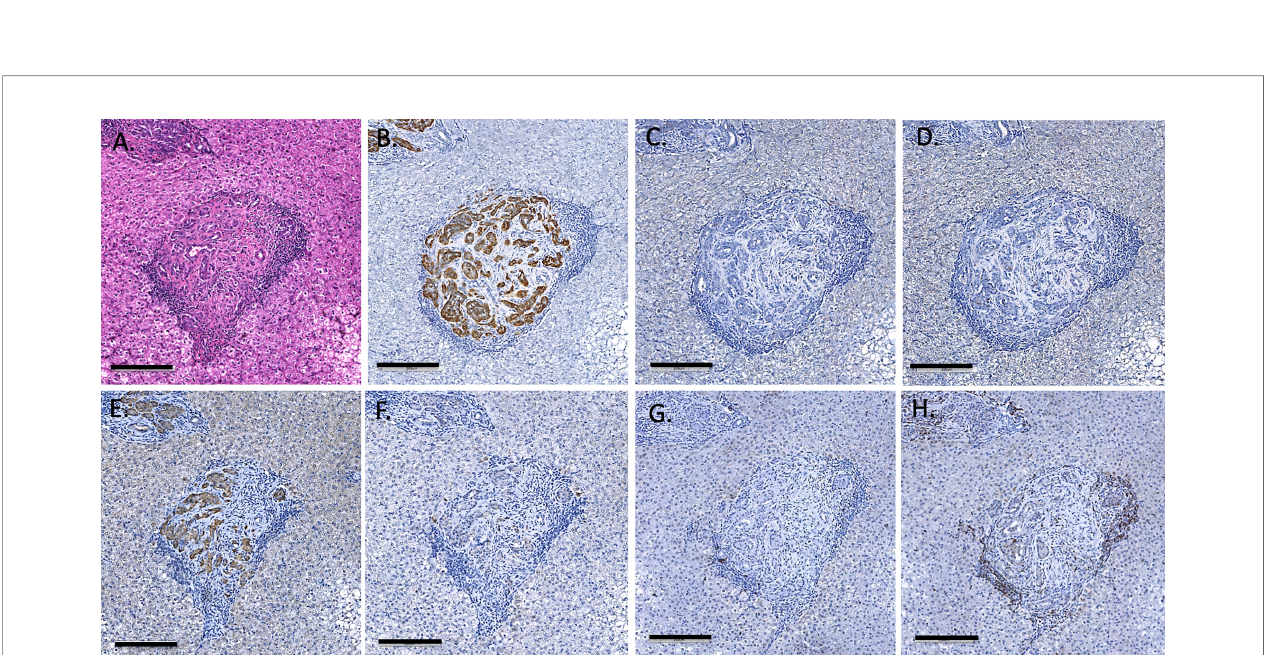
FIGURE 10 | Endpoint (day 675) liver biopsy of recipient B1, showing large islets staining with H&E (A) insulin (B) , glucagon (C) , somatostatin (D) , CD55 (E) and CD59 (F) , CD20 (G) and CD3 (H) . Magni fi cation X200, indicator bar 100